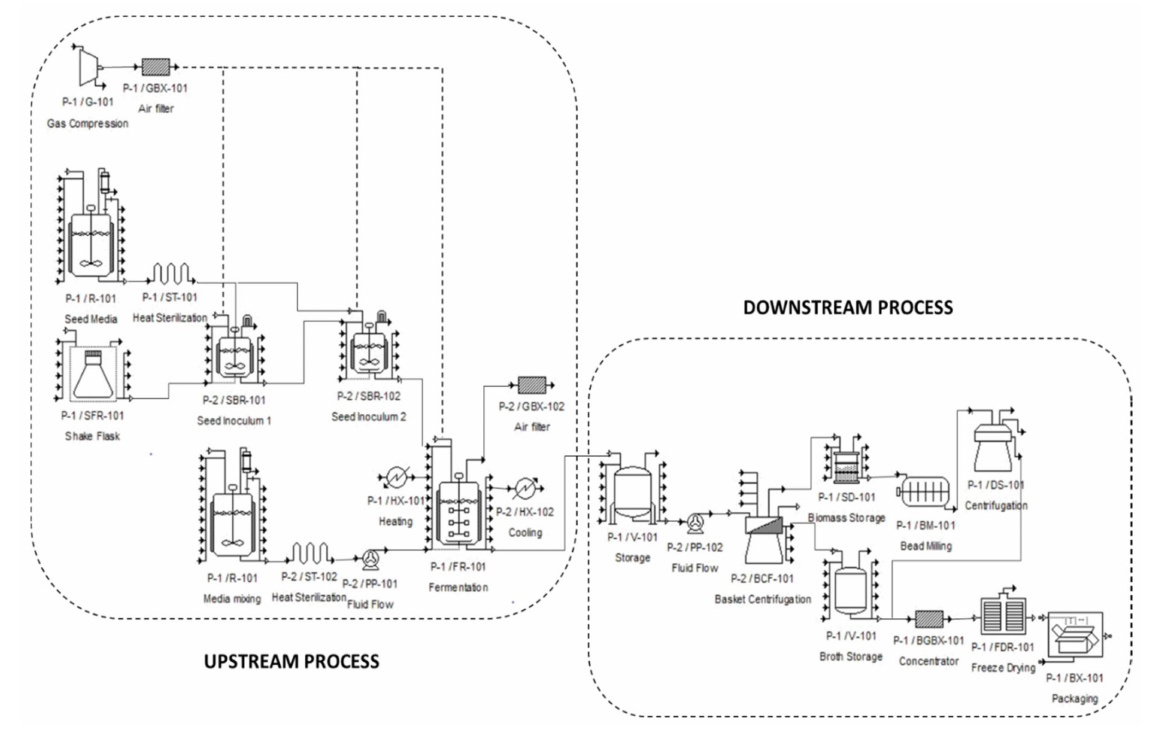
Figure 5. Schematic representation of large-scale submerged cellulase production. All the costs pertaining to total direct fixed capital and OPEX are tabulated in Tables 2–5. Table 2. Total direct fixed capital